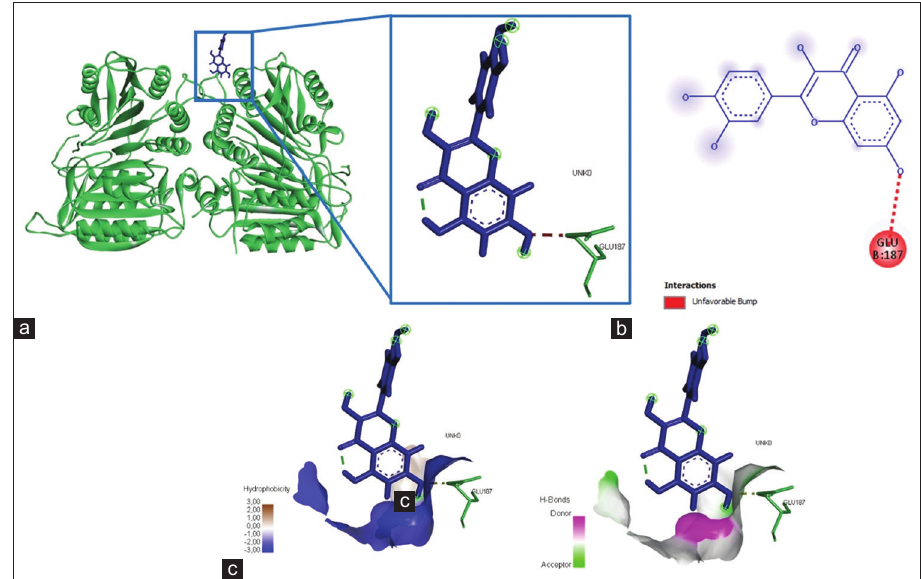
Figure-4: The three-dimensional and two-dimensional structure of the interaction between flavonoid compounds (quercetin) and caspase-9. (a) Three-dimensional structural interaction between flavonoid-ligand compound quercetin (blue) and caspase-9 on the active binding site (green). (b) This interaction is built by hydrogen and carbon-hydrogen bonds on the active site of caspase-9, namely, Glu187, which is seen in the two-dimensional (b) and three-dimensional (c)